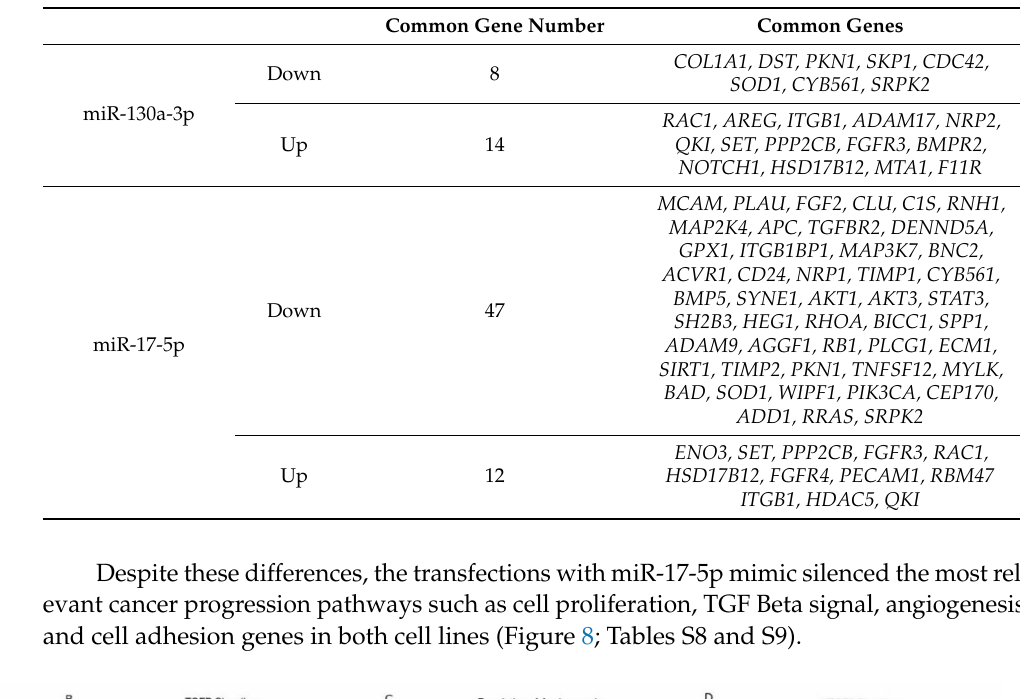
Table 8. List of the deregulated genes shared by two cell lines after transfections.